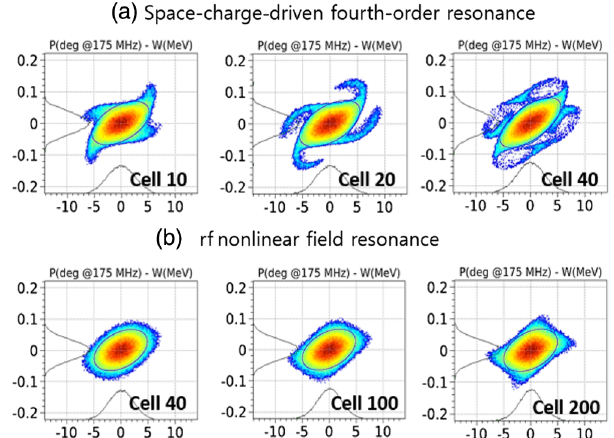
FIG. 10. The fourth-order resonances generated from a (a) non- linear space charge field and (b) rf nonlinear field. In (a), the space-charge-driven fourth-order resonance occurs from cell 10, and resonance islands are clearly observed in the phase plane. In (b), the rf nonlinear field resonance is much weaker and begins to appear after cell